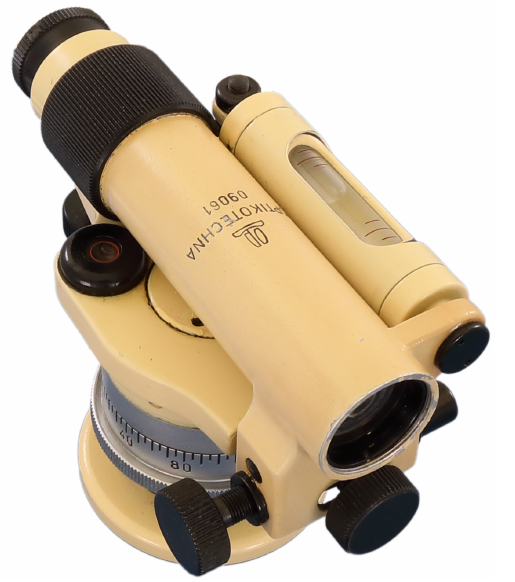
Figure 7. Levelling instrument by Optikotechna company (photo supplied by